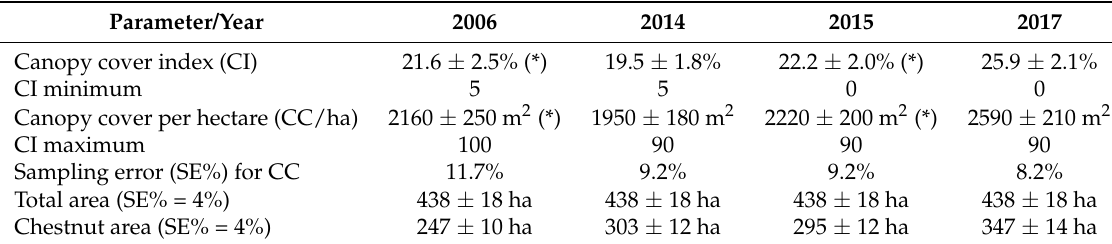
Table 1. CI and chestnut area for the period of the study (2006–2017). The sampling error is according to Student’s t-distribution. The average values with (*) are significantly equal.